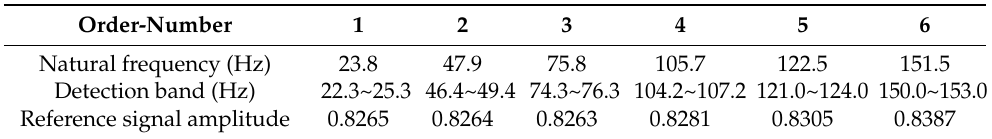
Table 2. The frequency bands for the detecting signal.